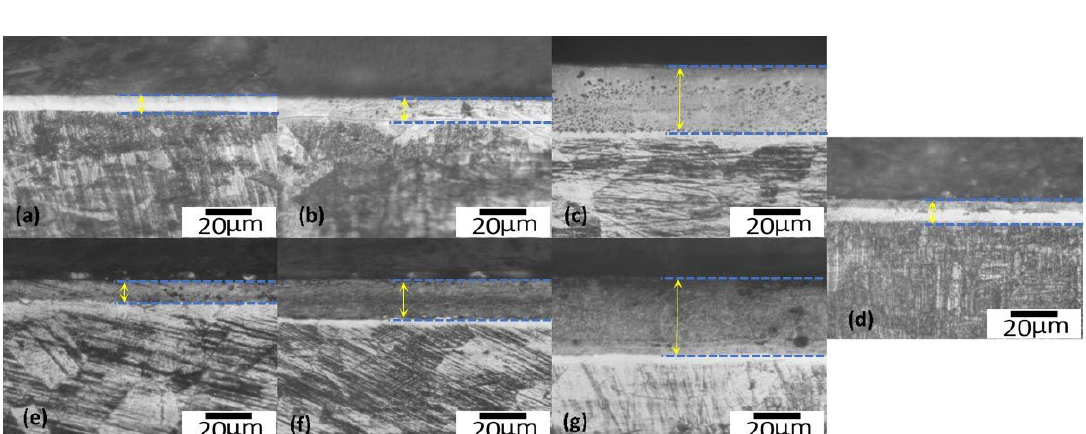
, (e) CPN400+MoO , (f) CPN450+MoO x x x